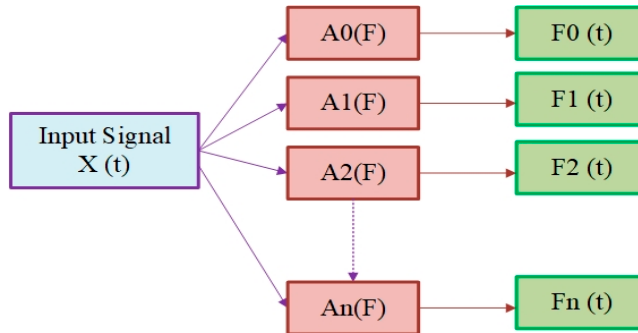
Figure 2. Analysis of digital filter bank .